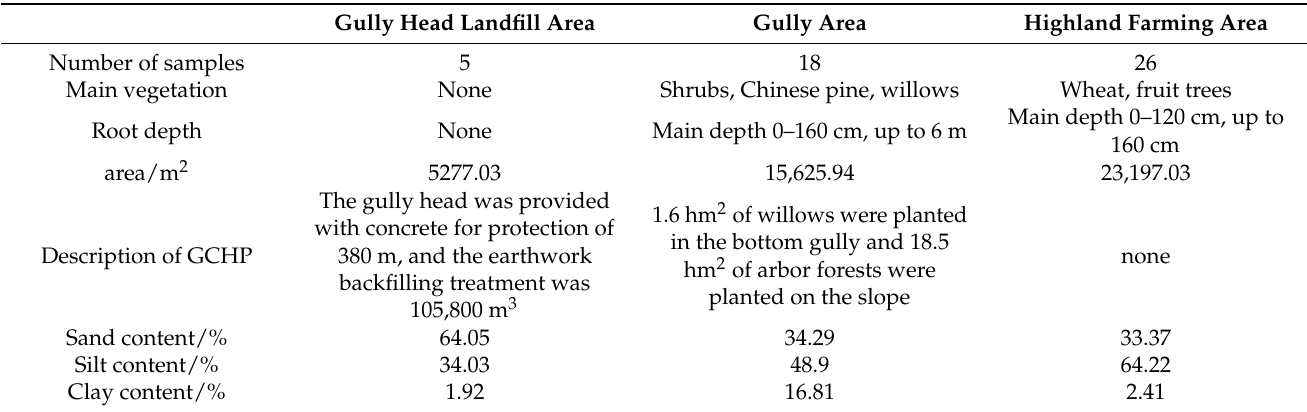
Table 1. Main characteristics and sampling numbers in the different